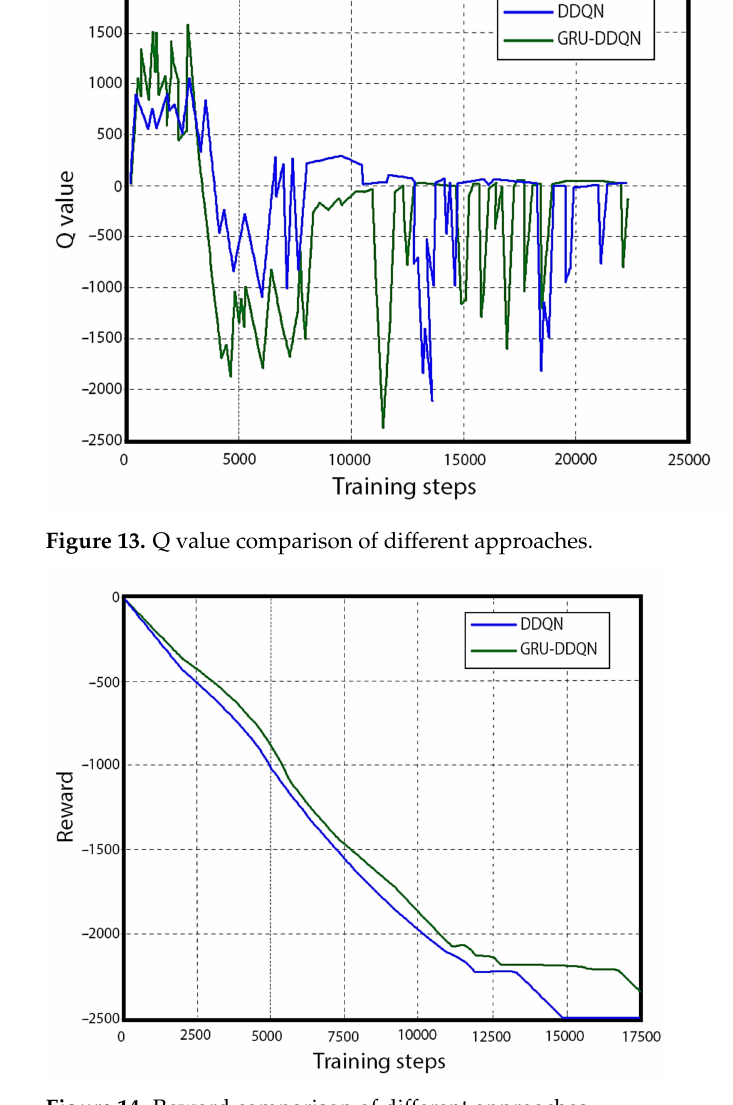
Figure 14. Reward comparison of different